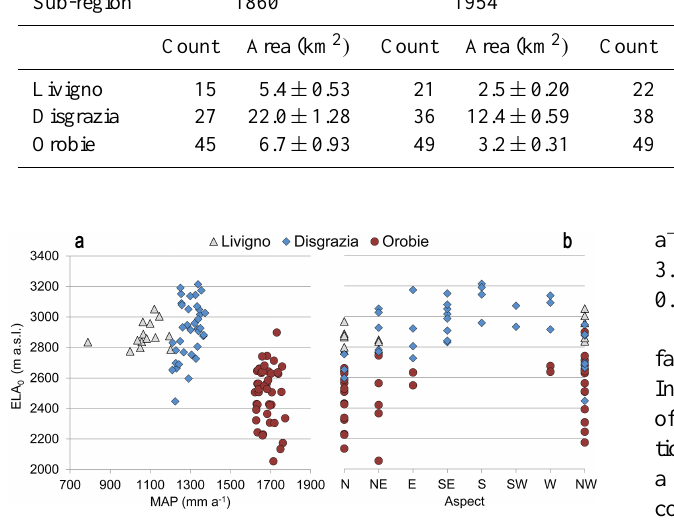
Figure 5. Balanced budget equilibrium line altitude (ELA 0 ) as a function of (a) mean annual precipitation (MAP) and (b) slope as-